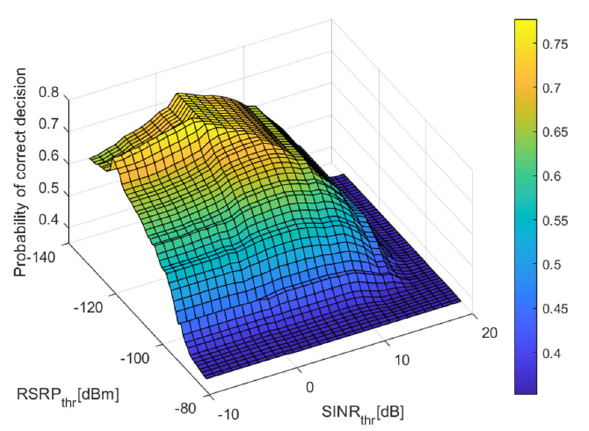
Figure 6. The probability of correct decision for different threshold values for RSRP and SINR, while the threshold for RSRQ was set to − 20 dB and the threshold for RSSI, was set to − 114 dB.